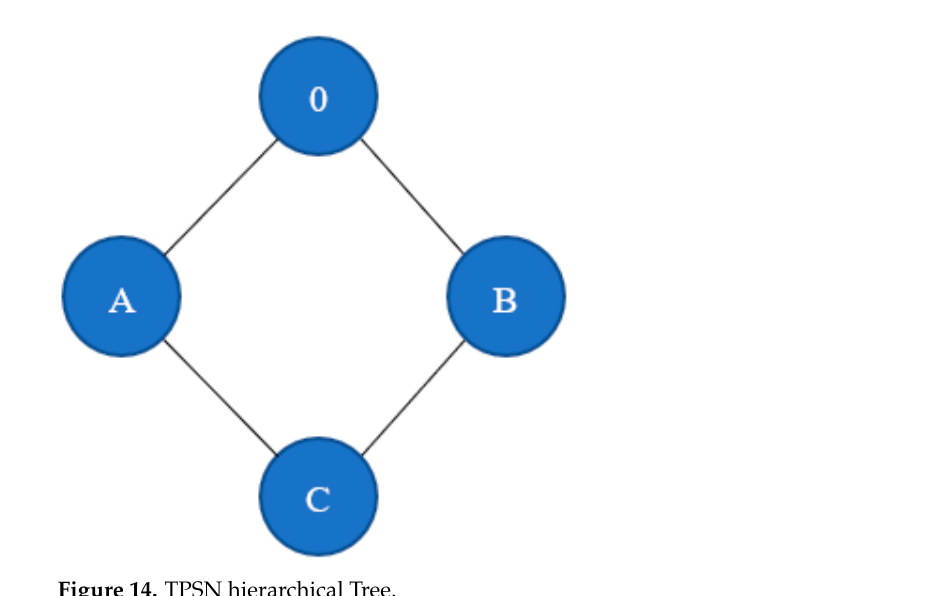
Figure 14. TPSN hierarchical Tree.